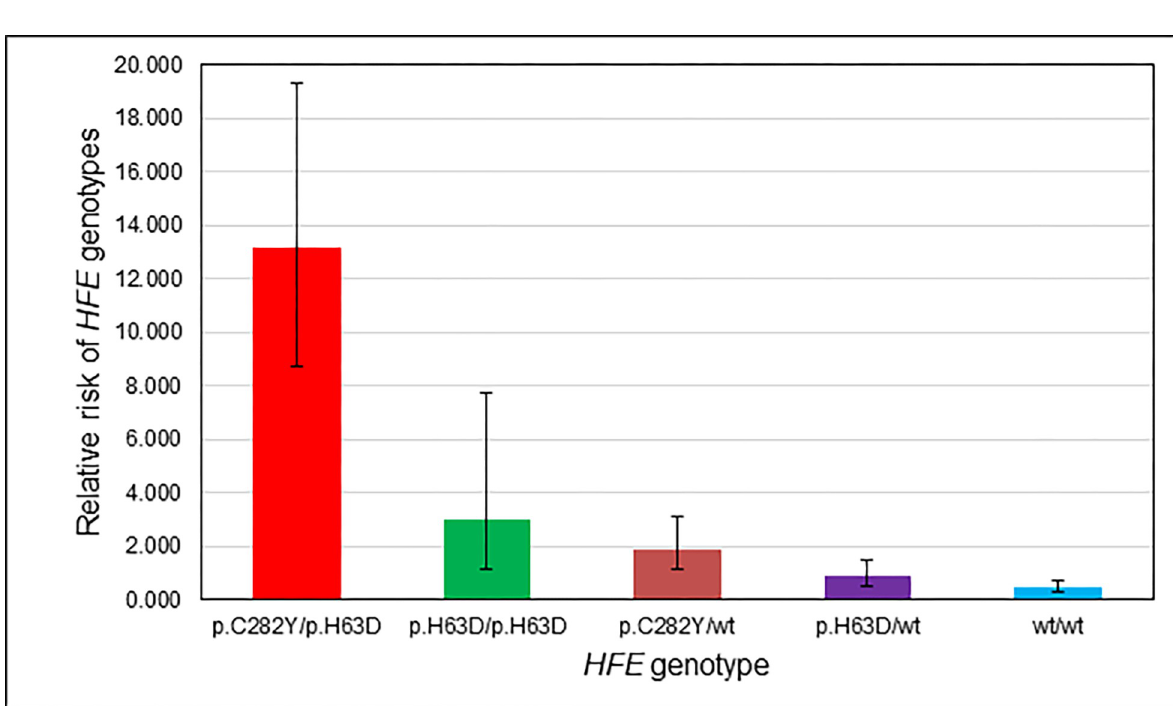
Fig 1. Relative risks (95% CI) of HFE genotypes in 58 non-Hispanic white post-screening clinical examination participants who had iron overload phenotypes without HFE p.C282Y/p.C282Y. Comparators were 42,640 non-Hispanic white HEIRS Study screening participants who had neither IO phenotypes nor p.C282Y/p.C282Y (see Table